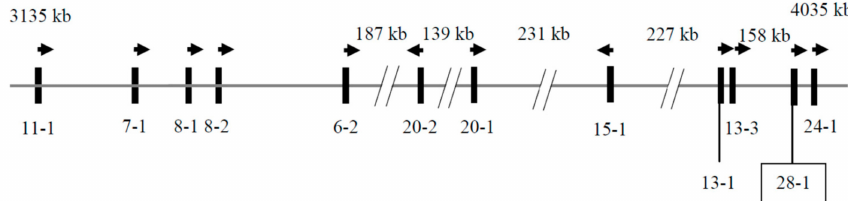
Figure 1. Location of KRTAPs on caprine chromosome 1. The identified KRTAP28-1 sequence is shown in the box, together with eleven previously identified KRTAPs . The vertical bars represent the KAP genes and the names of these genes are identified below the bars (e.g., 28-1 represents KRTAP28-1 ). The arrows indicate the direction of transcription. The spacing of these genes is only approximate and is based on the Caprine Genome Assembly, as are the nucleotide coordinates.